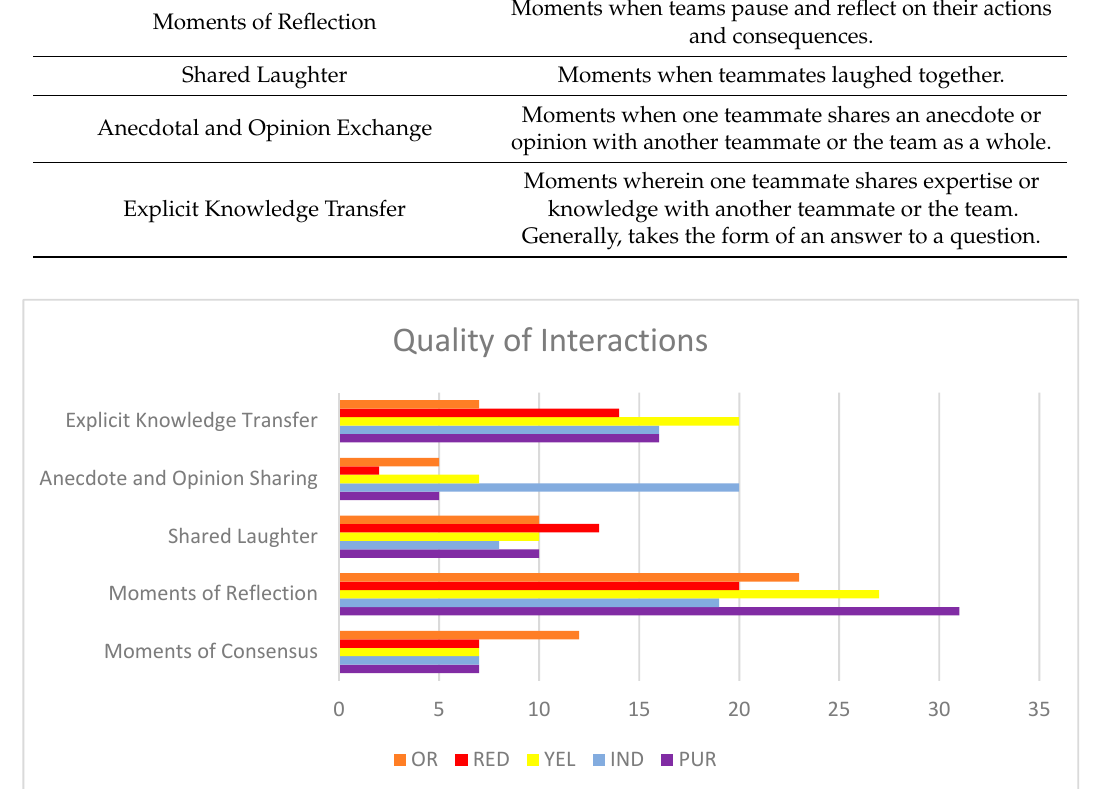
Figure 2. Summary of quality of interactions by team.